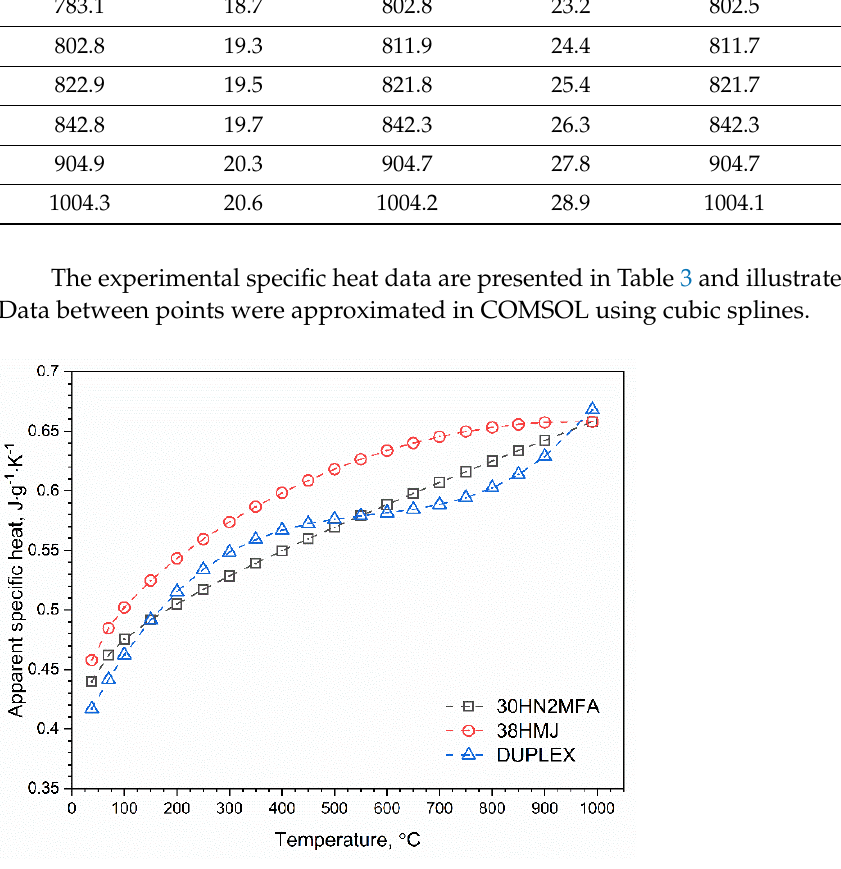
Figure 4. Apparent specific heat of chosen barrel steels: 30HN2MFA, 38HMJ, DUPLEX [12]. Table 3. Data on apparent specific heat of selected barrel steels [12].